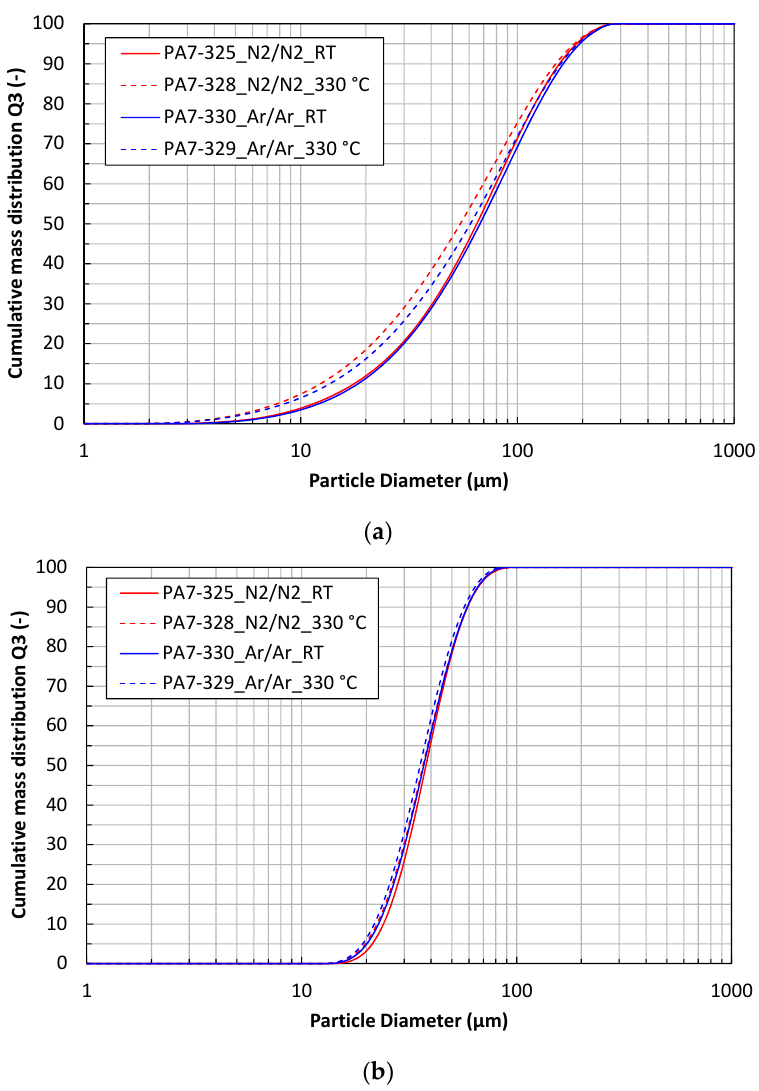
Figure 2. Particle size distributions of the X2CrNiMoCuWN25-7-4 powder atomized with different process gases and gas temperatures. ( a ) Powder fraction < 200 µm; ( b ) powder fraction 20–63 µm. Table 5. Particle size parameters of the powder fraction < 200 µm.